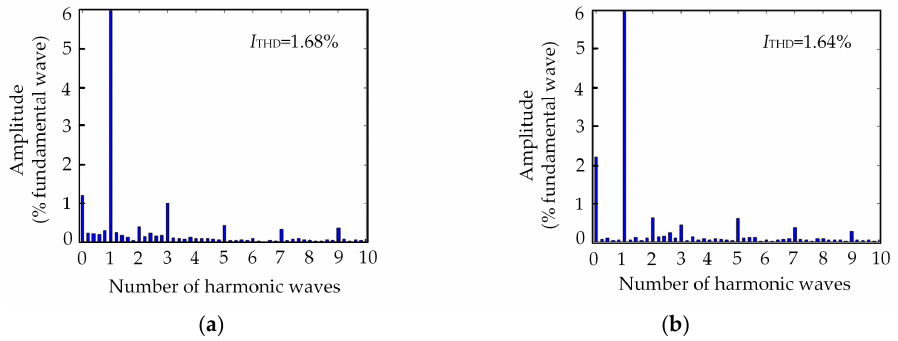
Figure 23. Experimental output waveforms of the converter at cos φ = 0.623 ( N = 4). ( a ) The proposed modulation method, ( b ) the conventional modulation method.